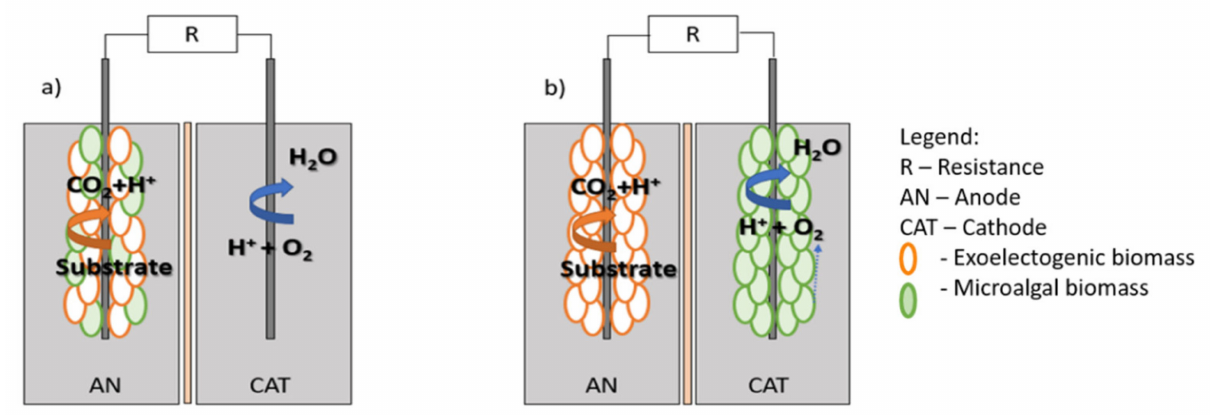
Figure 2. Schematic of microalgae integration in BES: ( a ) Integrated Photo-Bioelectrochemical (IPB) system, ( b ) algal biocathode system